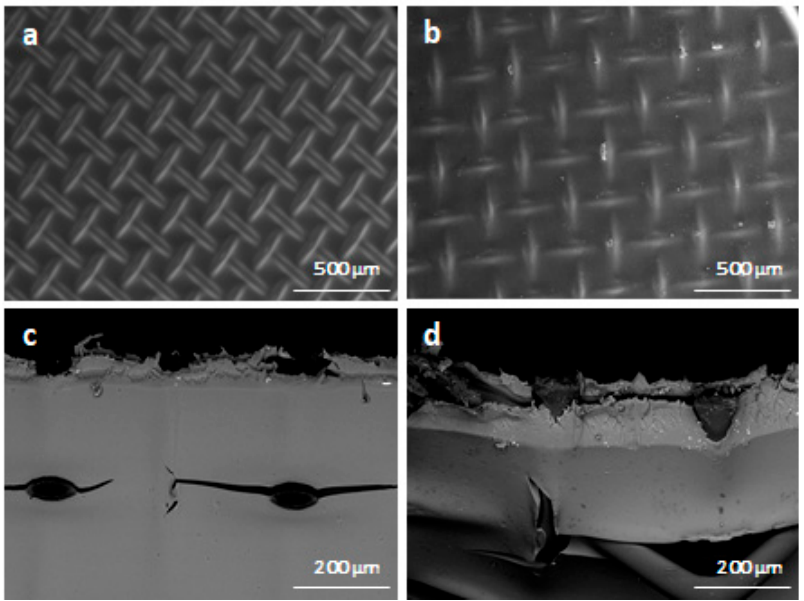
Figure 4. Scanning electron microscopy images detailing membrane state before use (( a ) surface, ( c ) cross-section)) and after use (( b ) surface, ( d ) cross-section).